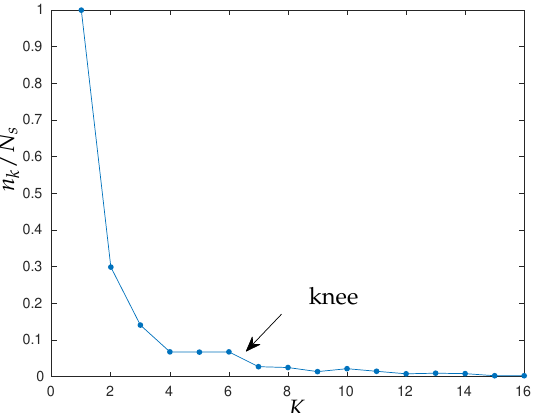
Figure 3. Fraction of samples n k / N s in the smallest cluster versus the number K of clusters. Fraction of samples n k / N s in the smallest cluster has a knee and reduces to about 2%. This means that the Gaussian components in excess of six account for very small fractions of samples and thus are statistically negligible. For the considered example, K = 6 is an adequate number of Gaussian components.